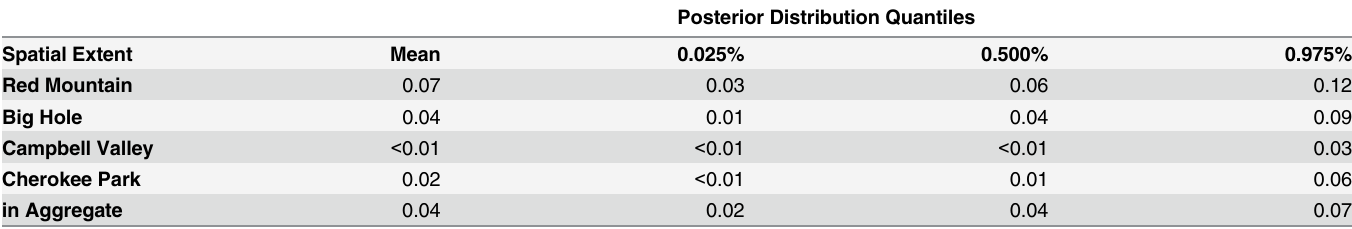
Table 1. Estimates of annual CWD infection